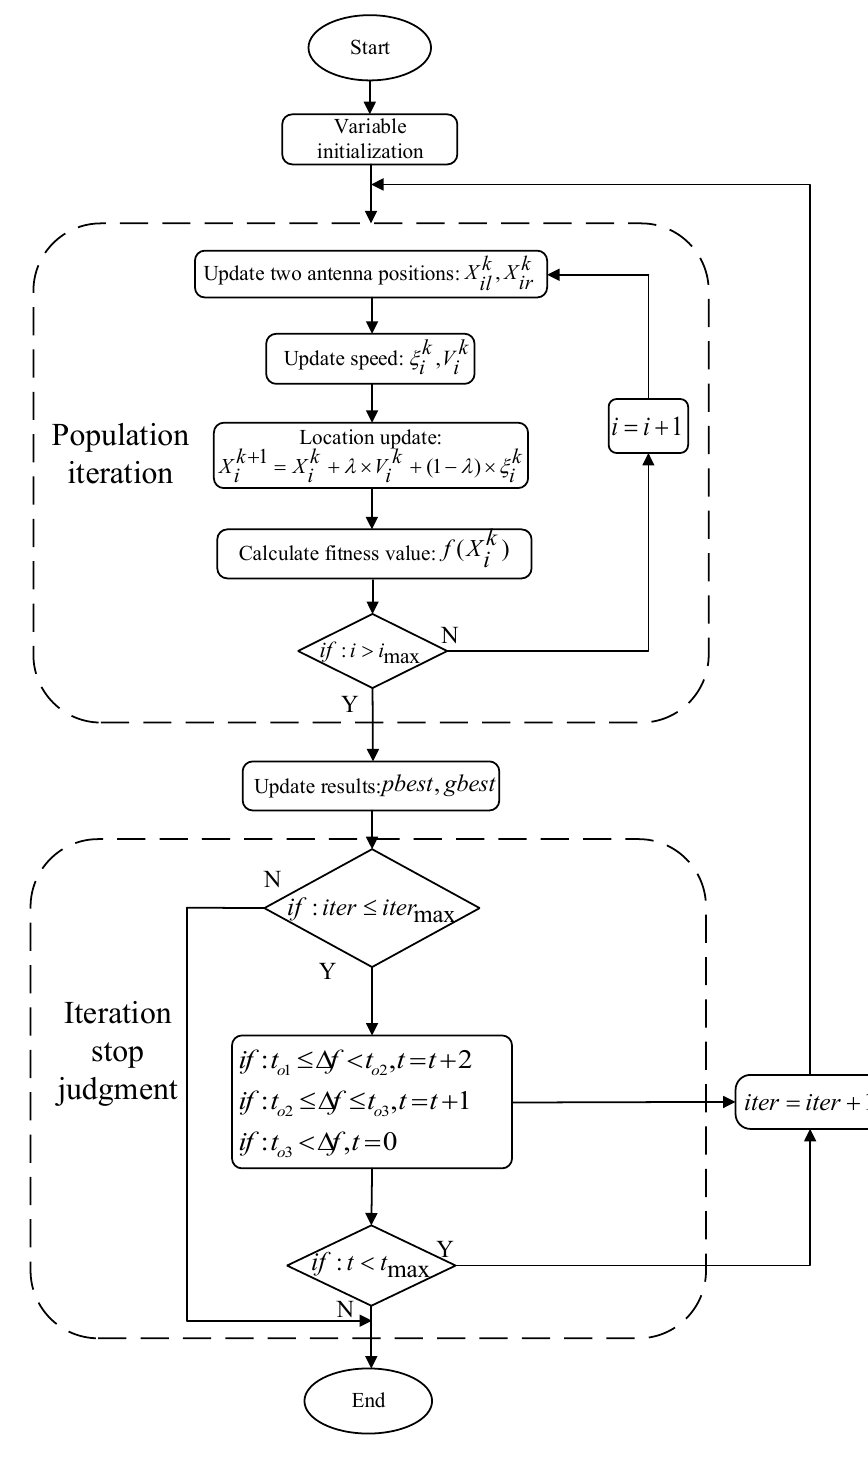
Figure 3. Solving process of BAS ‐ PSO.